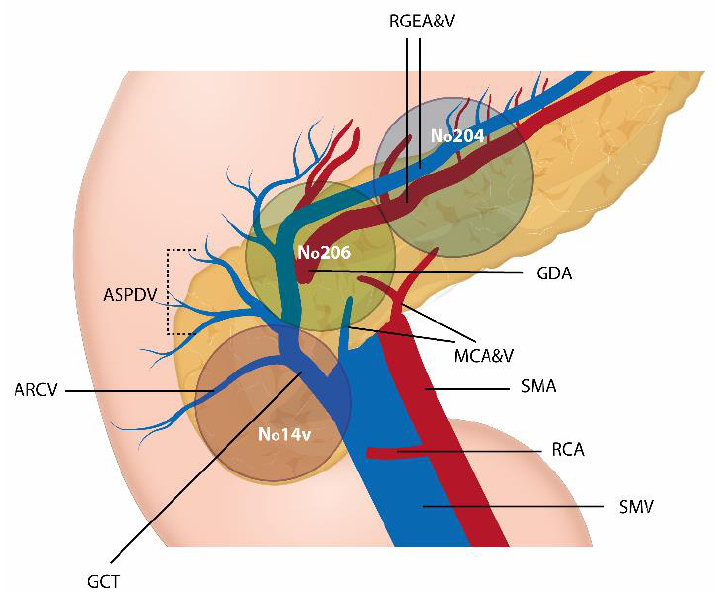
Figure 1. GCLN placement in relation to the mesenteric vessels, pancreas and stomach: gastroepiploic LN (No. 204), infrapyloric LN (No. 206) and superficial pancreatic LN (No. 214v). RGEA&V, Right Gastroepiploic Artery and Vein; ASPDV, Anterior Superior Pancreaticoduodenal Vein; ARCV, Accessory Right Colic Vein; GCT, Gastrocolic Trunk; GDA, Gastroduodenal Artery; MCA&V, Middle Colic Artery and Vein; SMA, Superior Mesenteric Artery; RCA, Right Colic Artery; SMV, Superior Mesenteric Vein.